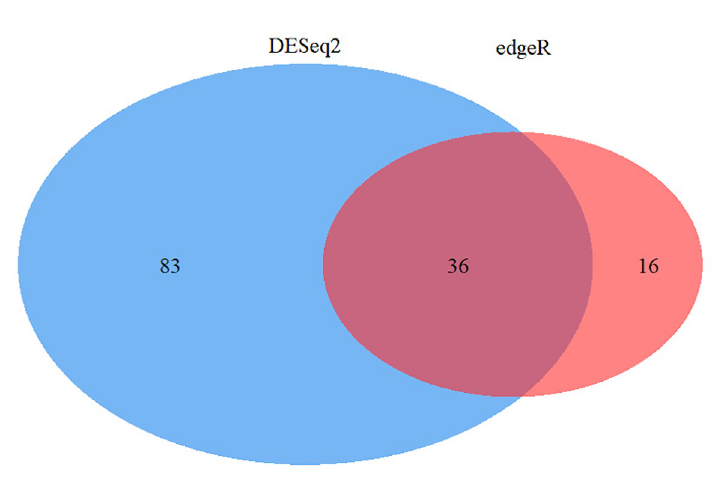
Fig 1. Number of DEGs identified in high risk beef cattle at arrival. Venn diagram of the number of differentially expressed genes found in edgeR and DESeq2 analysis.